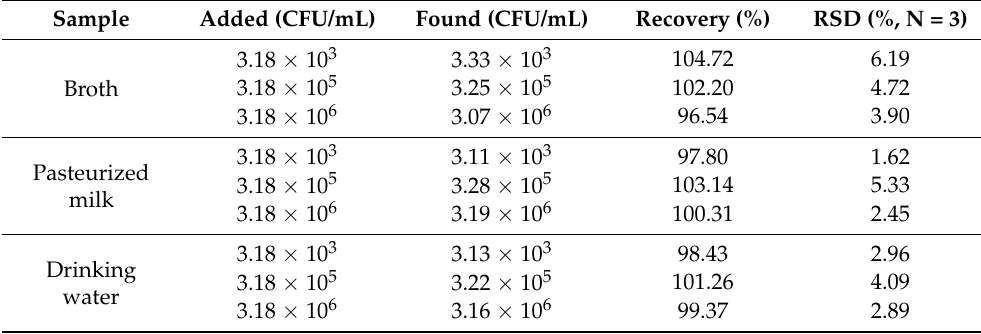
Table 1. Recovery study of this biosensor in real